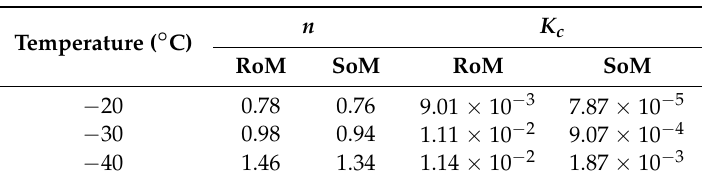
Table 6. Variation of crystallization kinetic parameters with temperature; Avrami exponent, n and crystallization rate constant, K c